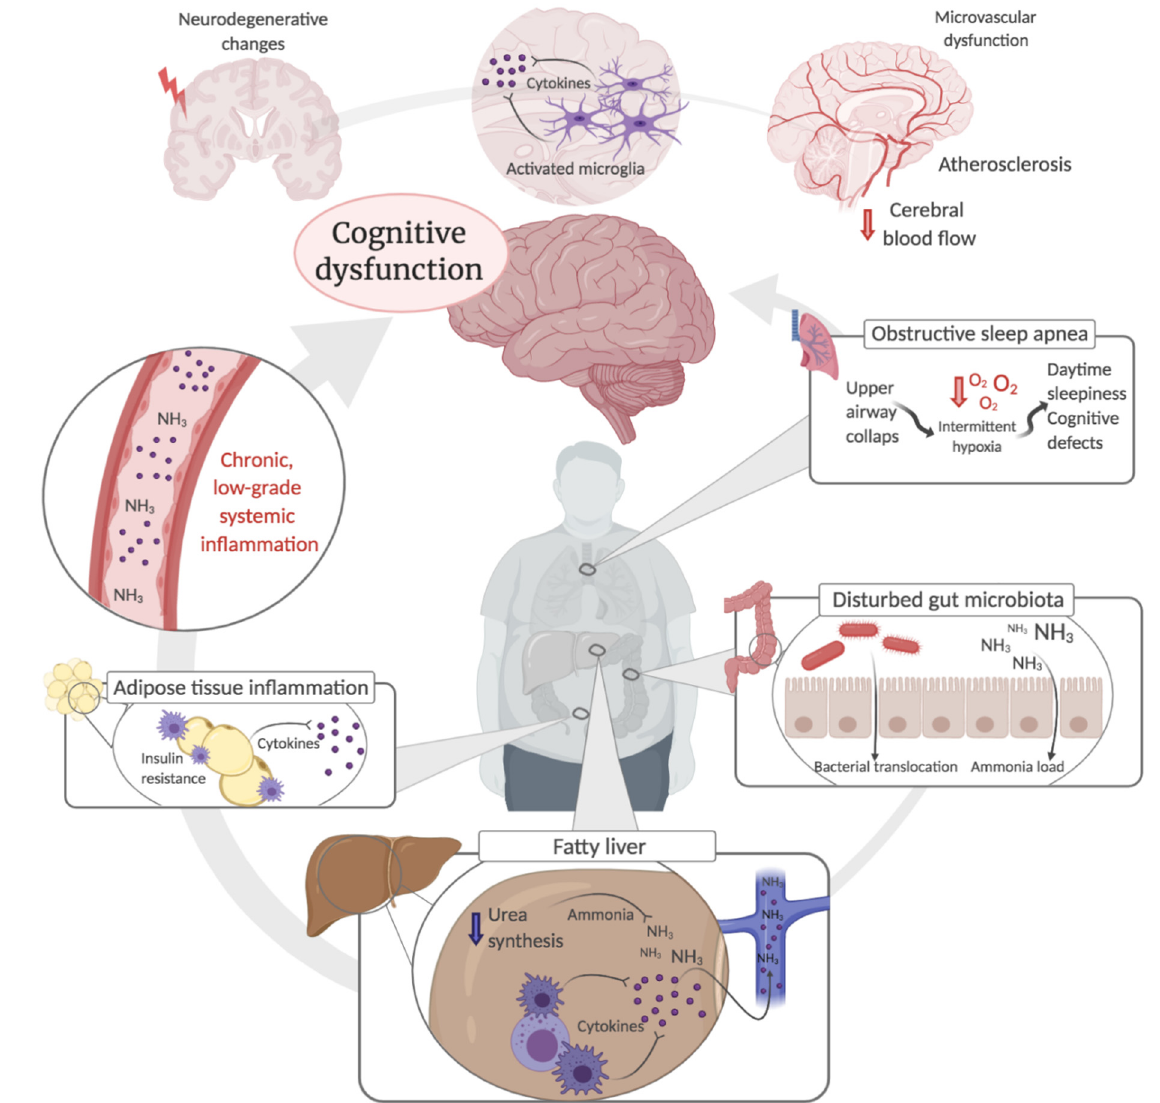
Figure 1. Possible mechanisms contributing to cognitive dysfunction in non-alcoholic fatty liver disease.